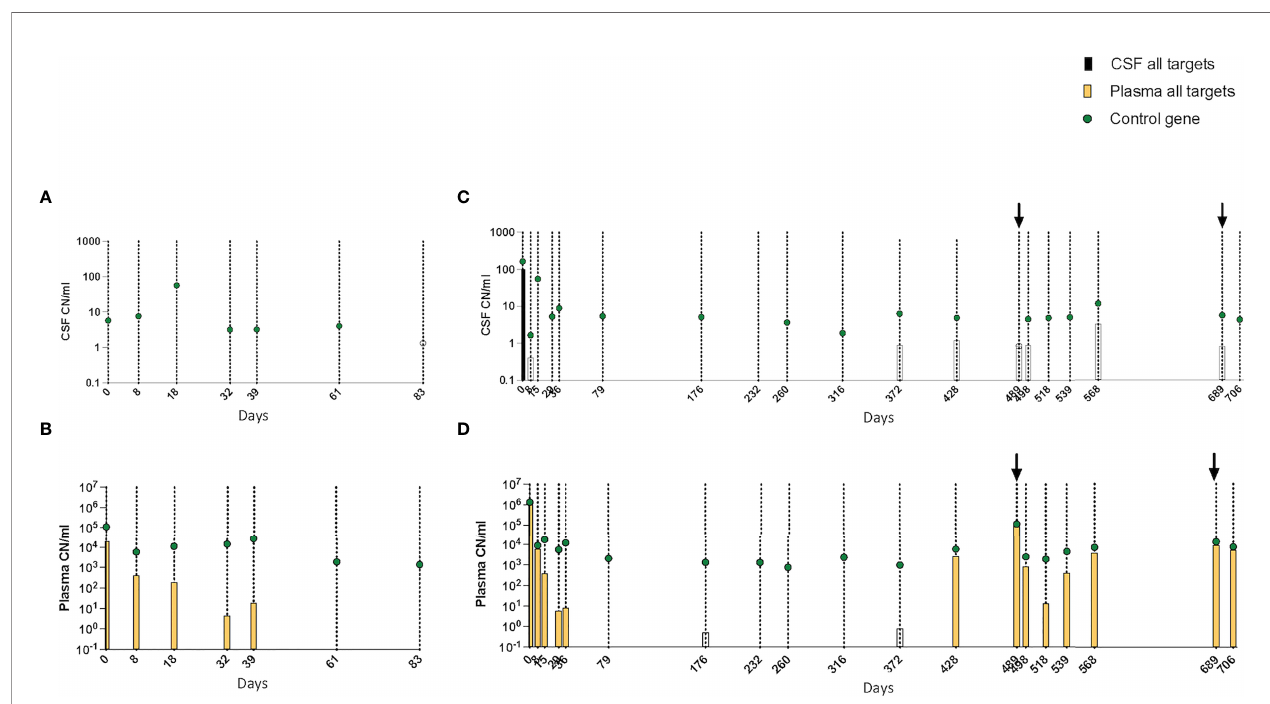
FIGURE 6 | (A – D) Kinetics of leukemic targets in CSF and plasma by ddPCR during treatment. (A) CSF and (B) plasma results in patient 3. (C) CSF and (D) plasma results in patient 4. Empty symbols denote trace values (1 – 2 positive droplets). CSF, cerebrospinal fl uid; ddPCR, droplet digital